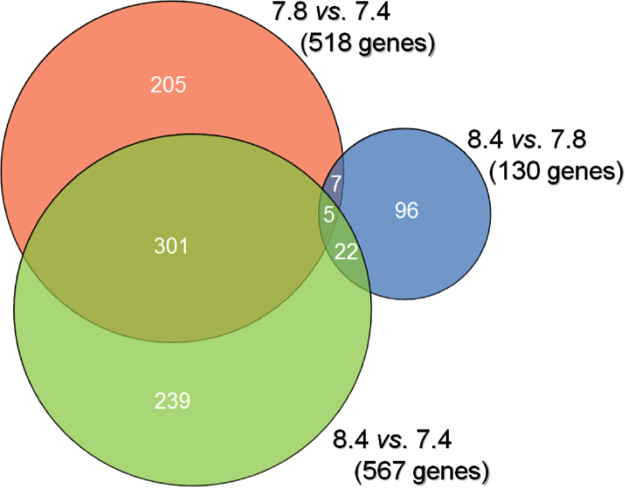
Venn diagram illustrating the numbers of genes, which were commonly and exclusively expressed at pH 7.8 and 7.4 (red circle), at pH 8.4 and 7.4 (green), as well as at pH 8.4 and 7.8 (blue).